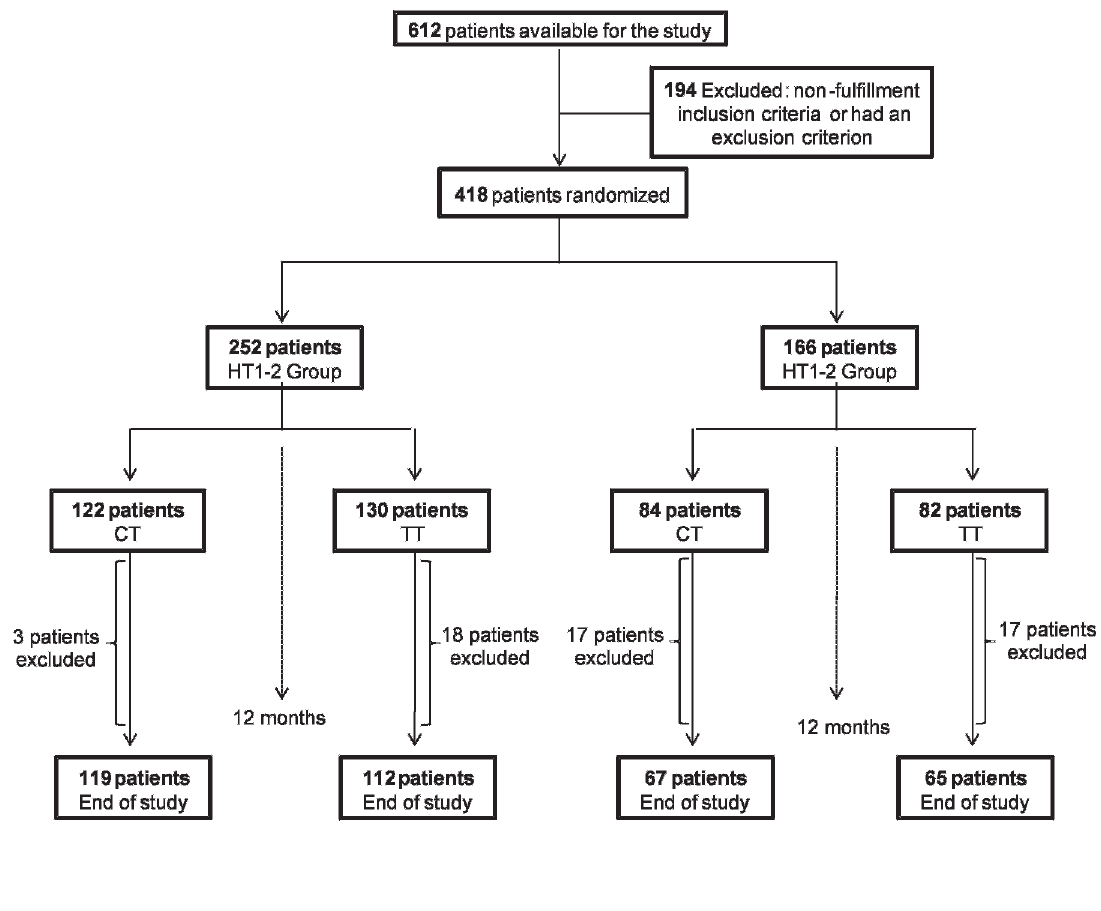
Figure 1 - Flowchart of the entry and discontinuation of patients for the pharmacoeconomic